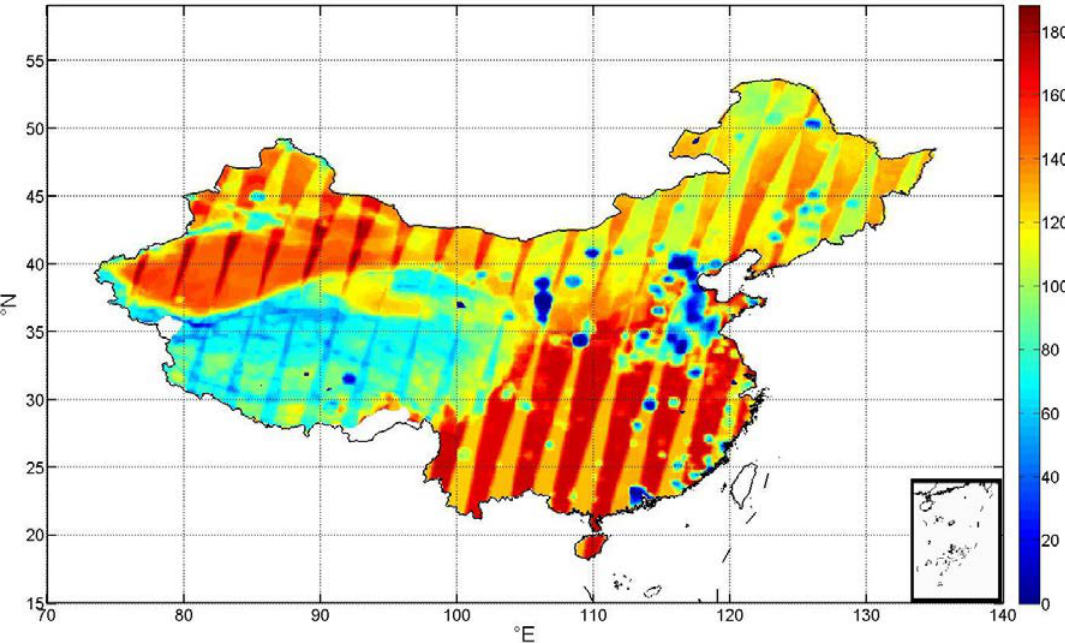
Figure 7. Frequency of SMAP overpass in China in 2017.